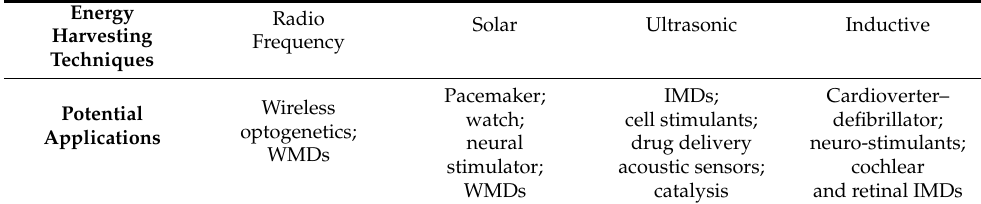
Table 5. Summary of potential applications of environment-centric energy